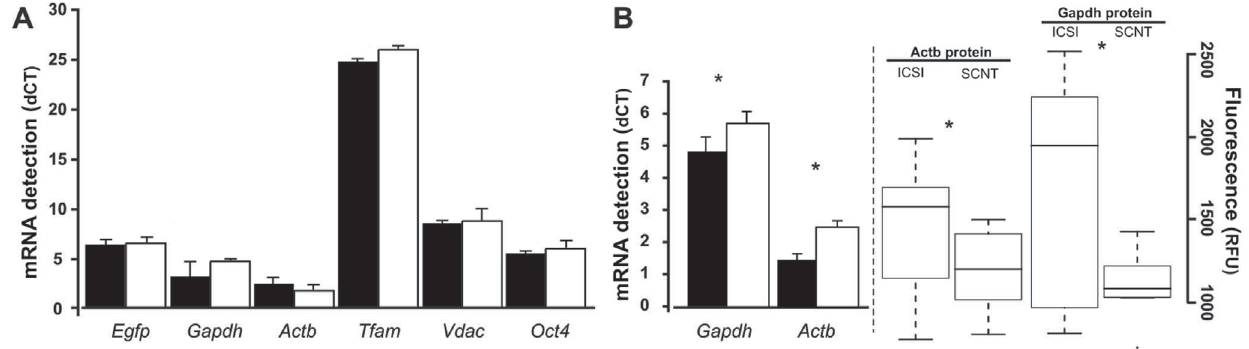
Figure 5. Transcription and translation in mouse blastocysts. mRNA levels were determined for pools of six ICSI and SCNT blastocysts (in duplicate), by quantitative RT-PCR, over two independent experiments. Technical replicates were determined three times for each sample, and results were normalized to Flag-Oct4 mRNA. (A) dCT values for transcripts in mtGFP-Tg SCNT, compared to ICSI. (B) dCT values for Gapdh and Actb mRNA, as well as protein levels (by immunocytochemistry), in wild-type SCNT relative to ICSI. Gapdh and Actb levels were significantly different, both for mRNA (t-test, p =0,001 and p =1,29E-08, respectively) and protein (t-test, p =0.006 and p =0.04, respectively). Box plot: fluorescence intensities distribution in the blastocyst; top and bottom lines: inter-quartile range; middle line: median; whiskers: range of variation limited to 1.5 times inter-quartile range.